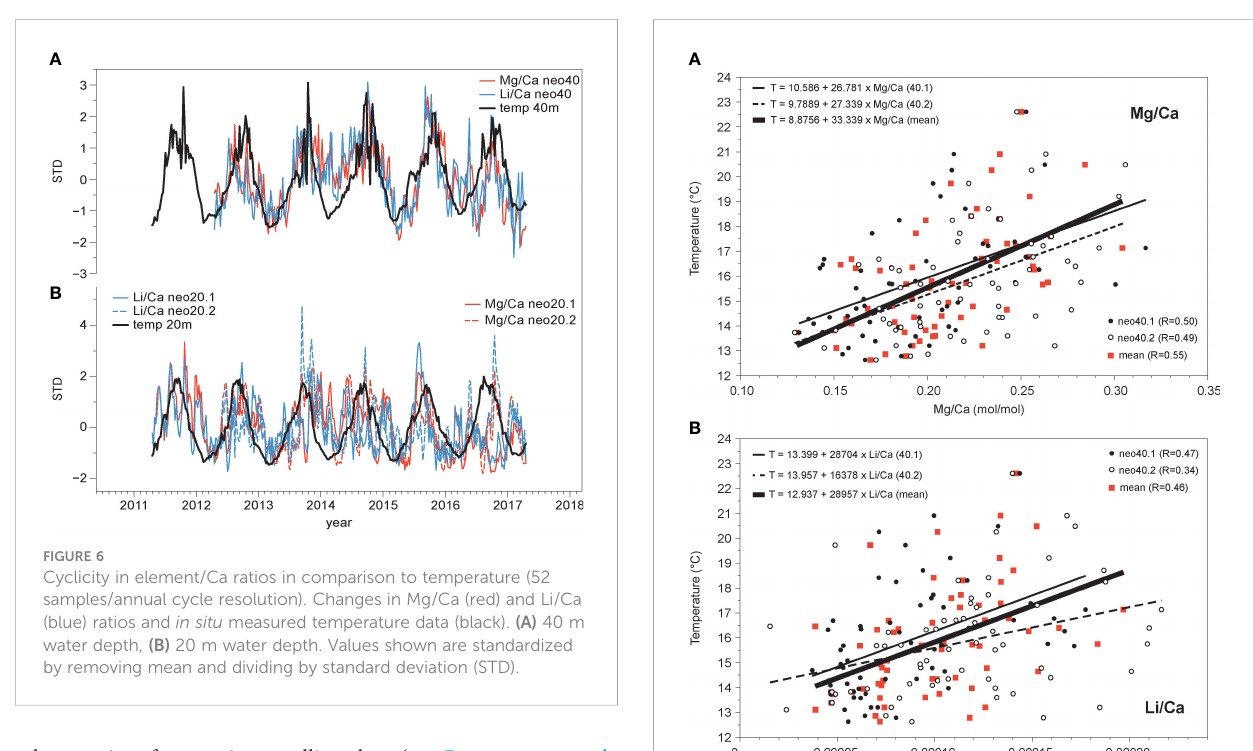
regressions are smaller than 0.01. Correlations of Mg/Ca and Li/ Ca ratios from sample neo20 to 20 m temperature are lower (Figure 8A, Mg/Ca: R=0.40 for transect neo20.2, R=0.24 for transect neo20.1; Figure 8B, Li/Ca: R=0.33 for transect neo20.2, R=0.29 for transect neo20.1).